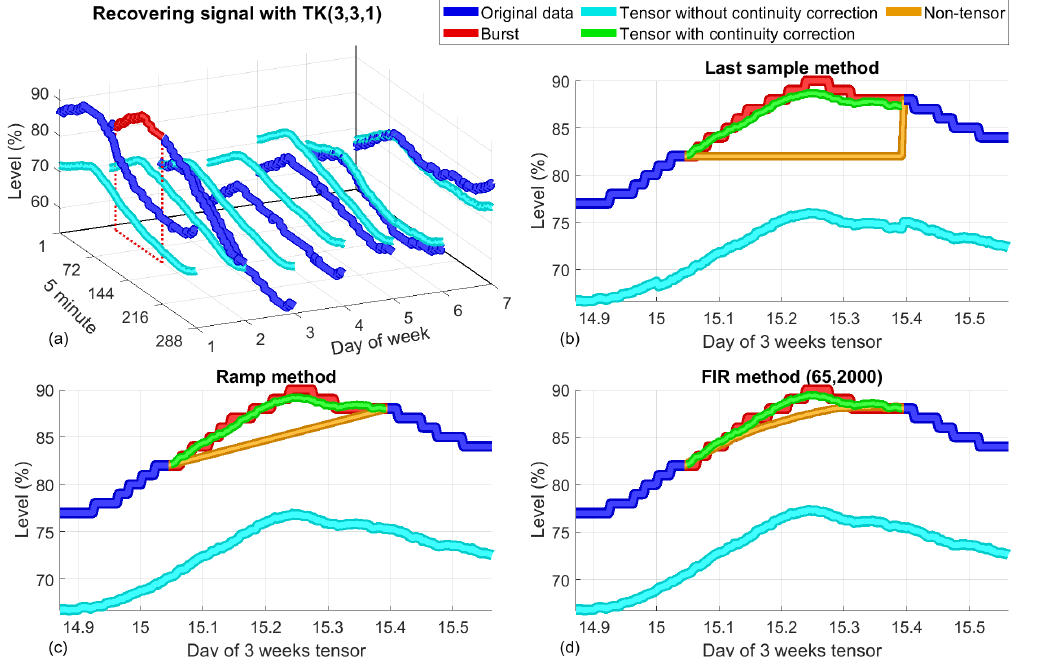
Figure 15. An example of the restoration stages. The tensor contains three weeks worth of data (288,7,3). The burst is 100 samples long, and its position is randomly selected: ( a ) shows the week of the tensor where the burst is located, χ ( :, :,3 ) , corresponding to week 3. Parts ( b – d ) show the three steps of the restoration process for the last sample , the ramp , and the FIR methods, respectively.